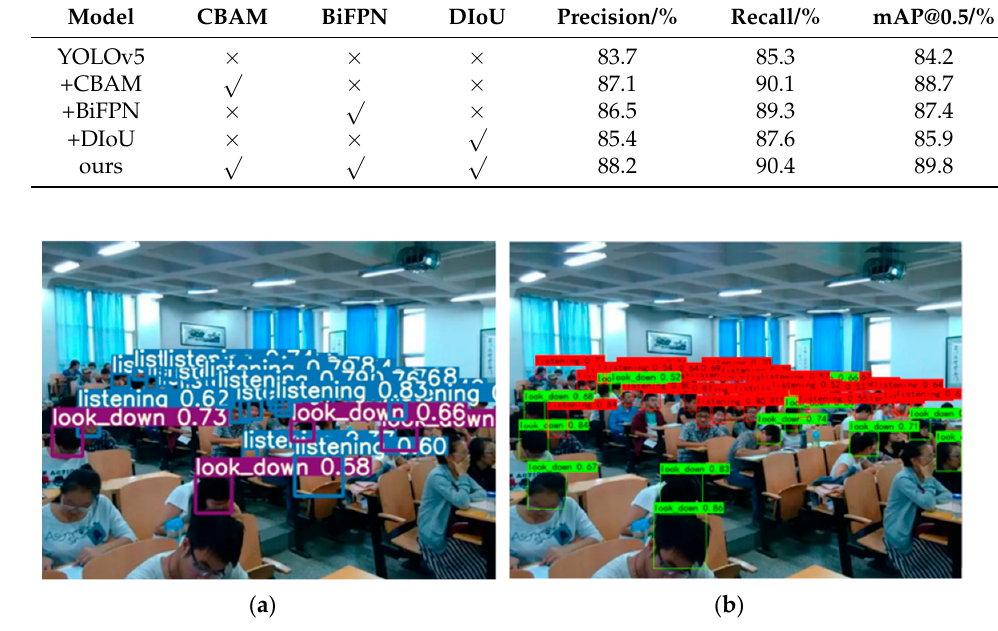
Figure 15. Comparison of dense scene detection effects. ( a ) YOLOv5. ( b ) Ours.